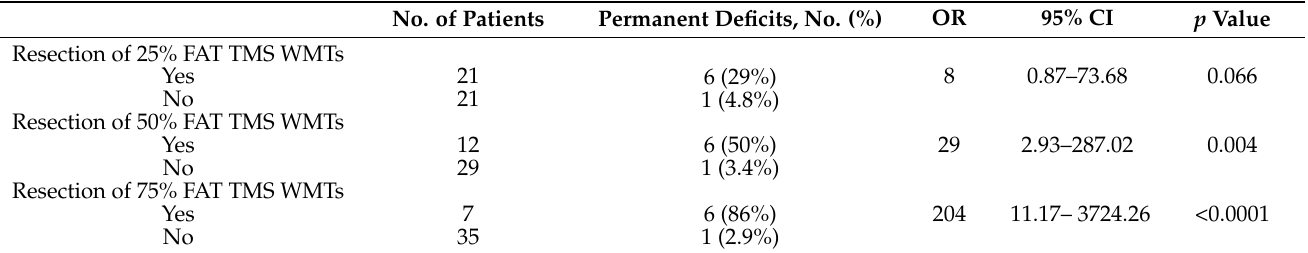
Table 4. Univariate binary logistic regression showing the predictive value of resection of TMS identified WMTs at various fractional anisotropic thresholds (FATs).